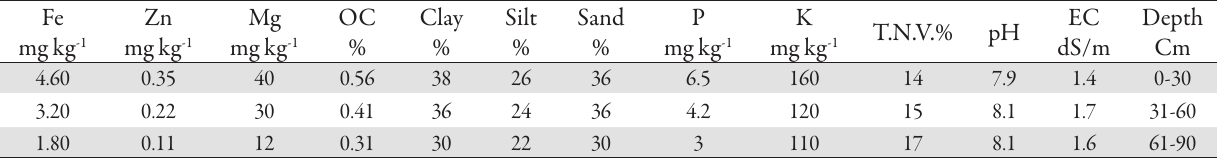
Tab. 1. Chemical and physical characteristics of the studied soil